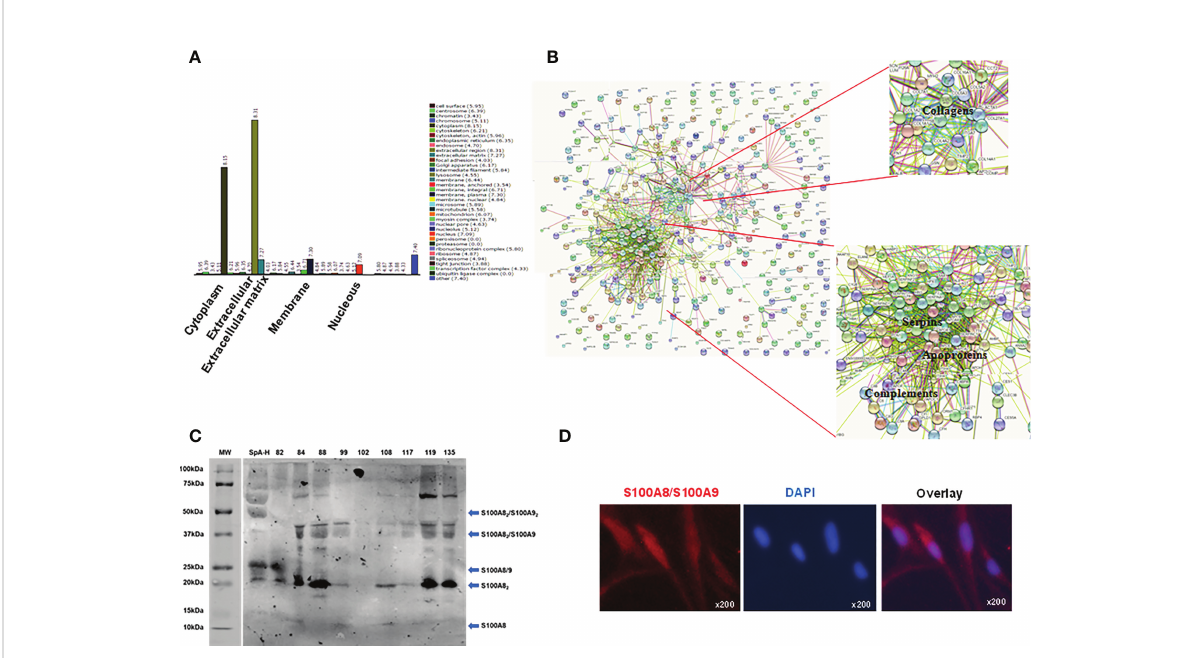
FIGURE 4 Proteins identi fi ed in peripheral SpA synovial fl uid and S100A8 detection. (A) Gene ontology identi fi ed 355 proteins in a pool of 9 SF of peripheral SpA pre-treated with hyaluronidase (the majority were extracellular and cytoplasmatic proteins). (B) Interactomics analysis by String- DB shows the most abundant proteins: complement proteins, apoproteins, serpins and collagens. (C) Western blot analysis showing immunoreactivity with the anti-S100A8/S100A9 antibody. Molecular weight (MW) markers, the SpA-H pool (1/20 dilution), and individual SpA synovial fl uids (1/20 dilution) were evaluated. Arrows indicate the observed S100A8 and S100A9 combinations. (D) Immuno fl uorescent detection of S100A8 (representative S100A8-positive fi broblasts), original magni fi cation